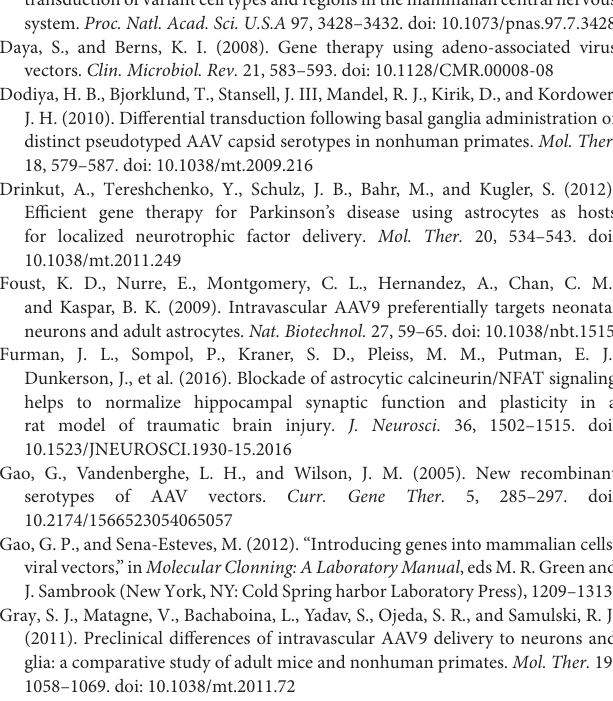
FIGURE S1 | Comparison of astrocytic transduction by rAAV serotypes 1, 2, and 5–9 obtained from a different viral packaging batch or from a